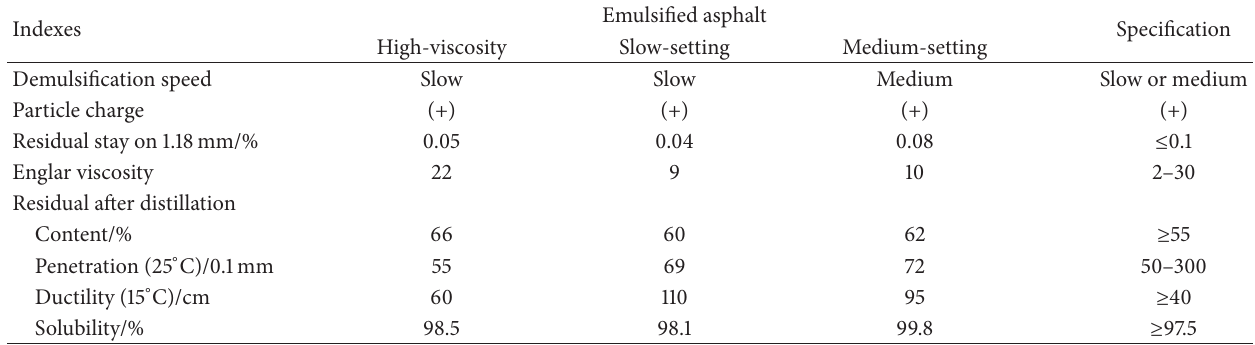
Table 3: Basic properties of emulsified asphalt.